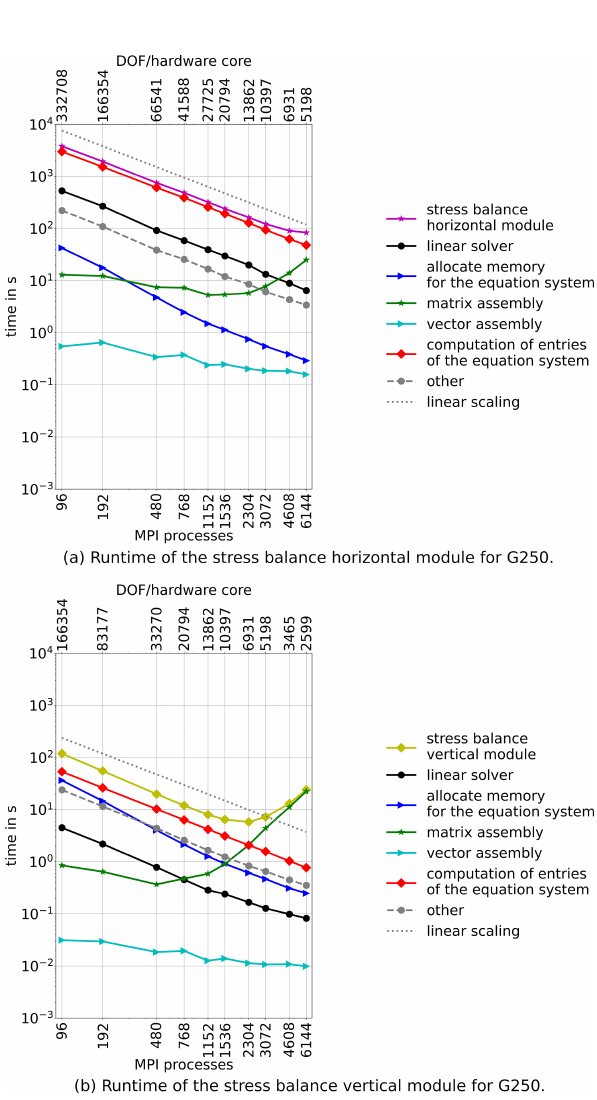
Figure 4. Runtime of the stress balance computation of ISSM Greenland model